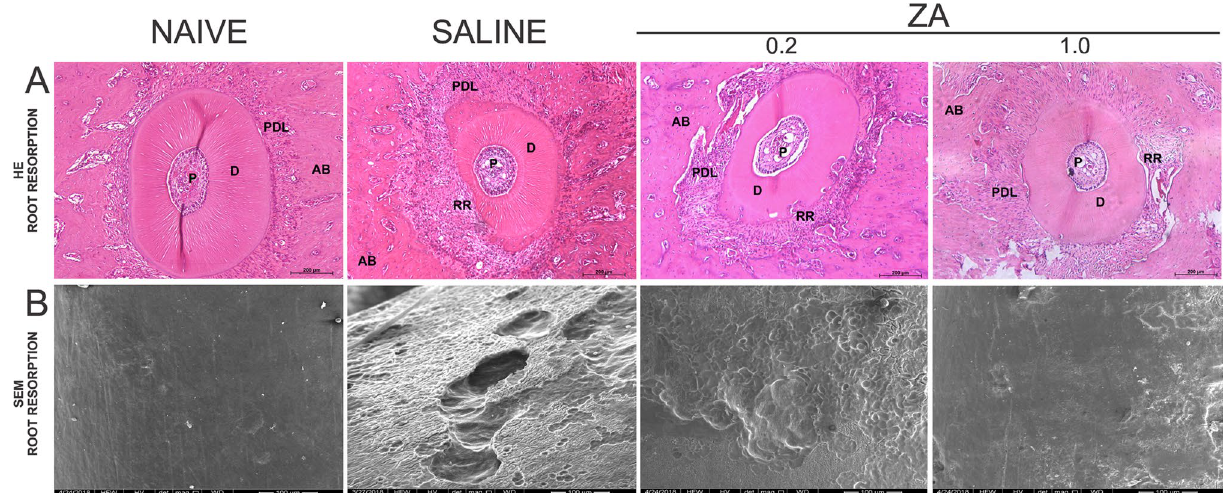
Figure 6. Analysis of root resorption in the Naive, Saline, ZA (0.2) and ZA (1.0) experimental groups. (A) Photomicrography of the distovestibular root. RR root resorption, PDL periodontal ligament, P pulp, D dentin, AB alveolar bone. The bars indicate 200 µm, HE staining, × 100 magnitude. (B) Electrophotomicrograph of the SEM analysis, the bars indicate 1 mm, ×